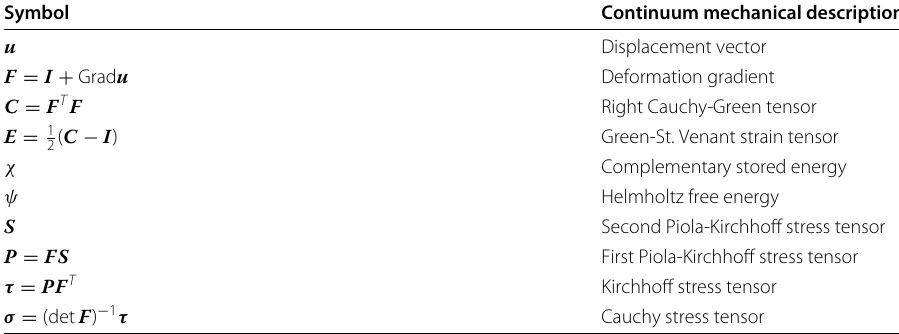
Table 1 Kinematics, constitutive quantities and stresses Symbol Continuum mechanical